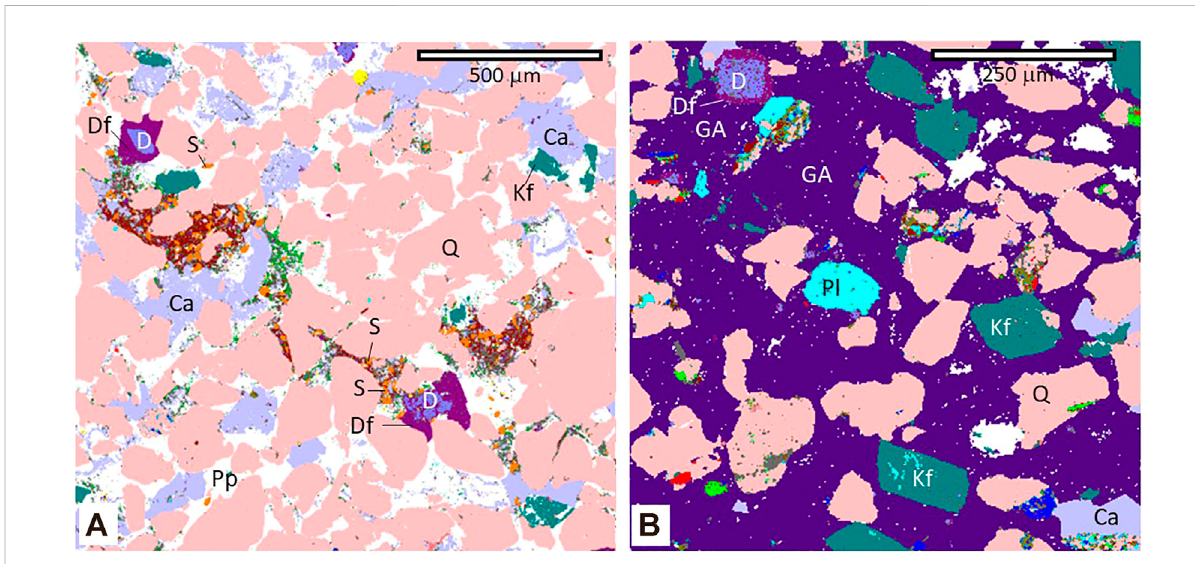
FIGURE 12 Dolomite,calciteandCa-sulphateinsandstones(mineralcolourindexinFigure3). (A) Highprimaryporosity(Pp)UpperJurassicshallowmarine sandstone, dominated by quartz (Q) with minor K-feldspar (Kf) from the Weald Basin. Dolomite (D) occurs as dispersed crystals with ferroan- dolomite (Df) rims and siderite (S) cement sitting on the outer edge of ferroan dolomite. Calcite (Ca) seems to sit on the outer edge of the ferroan dolomite,possiblysuggesting thatdedolomitisationhasoccurred. (B) Very fi nesandstonefromtheTarporleySitstoneFormation,atthebaseof the Mercia Mudstone Group, that is dominated by quartz with minor K-feldspar, from the East Irish Sea Basin. Dolomite (D) occurs as dispersed crystalswithferroan-dolomite(Df)rims.Calcite (Ca)cementsitsontopofferroan dolomitesuggesting thatcalcitewasthelastcarbonatecementto devlop. Gypsum cement (GA) has developed after the ferroan dolomite and calcite and this sulphate cement has here occluded most of the